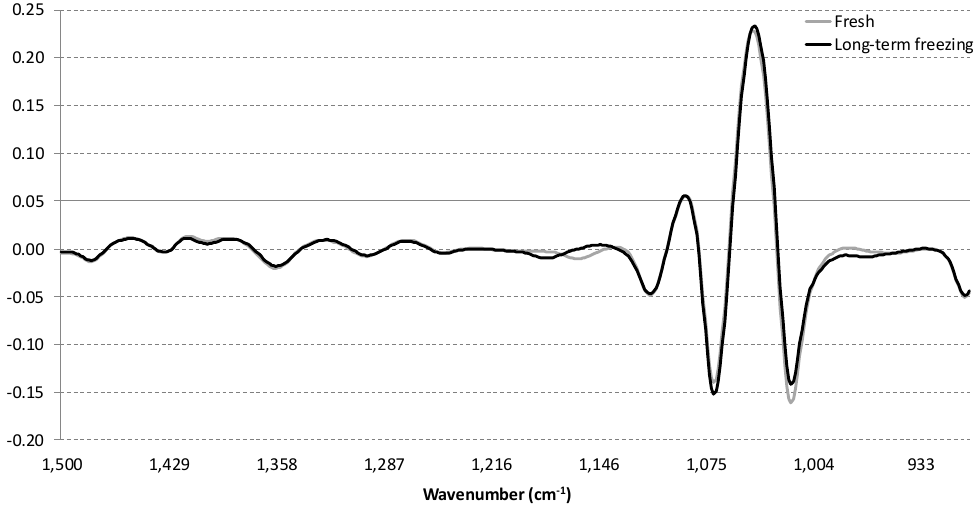
Figure 5. Loadings for the first PC for the MIR fingerprint region (1500–900 cm − 1 ) of carbonated beverages prior to storage (i.e., fresh and degassed) and following long ‐ term (6 week) freezing.